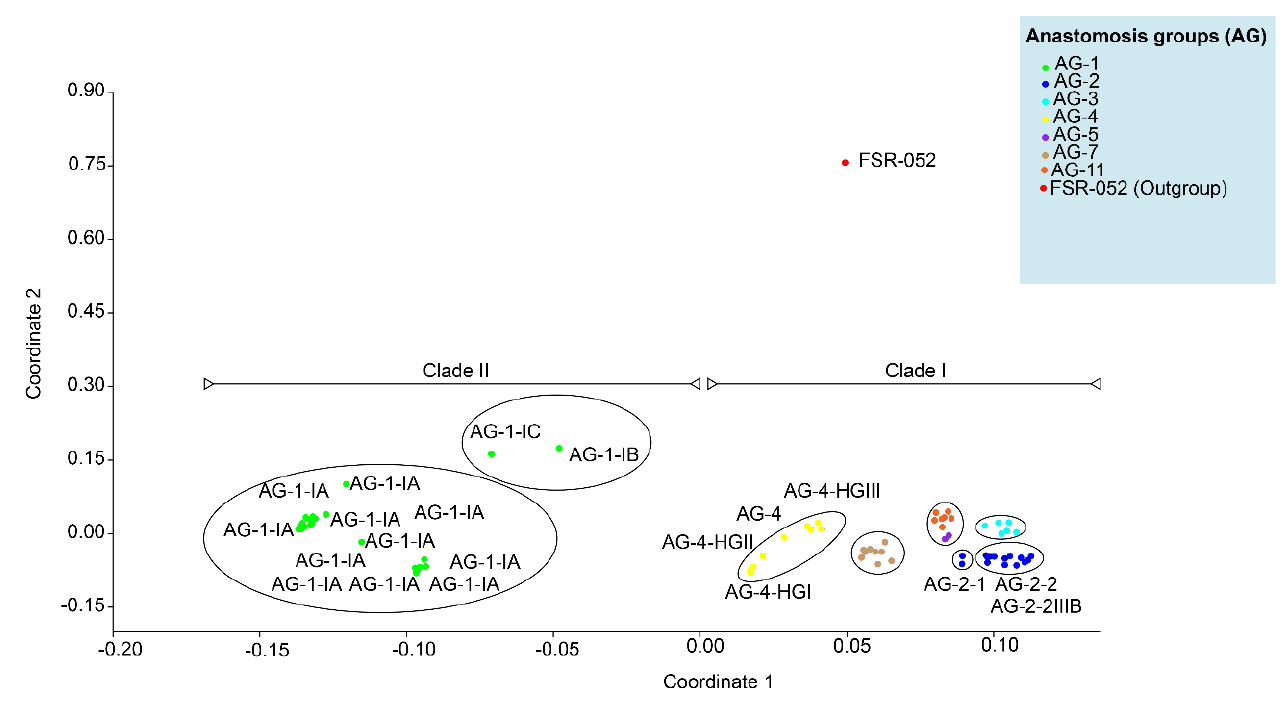
Figure 5. Principal coordinate analyses (PCoA) ordination of R.solani anastomosis groups. (AG) based on a Gower distance of sequence similarity matrix.